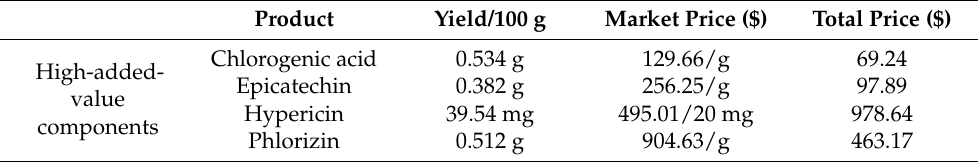
Table 6. Incomes related to the obtaining of monomeric phenols from thinned